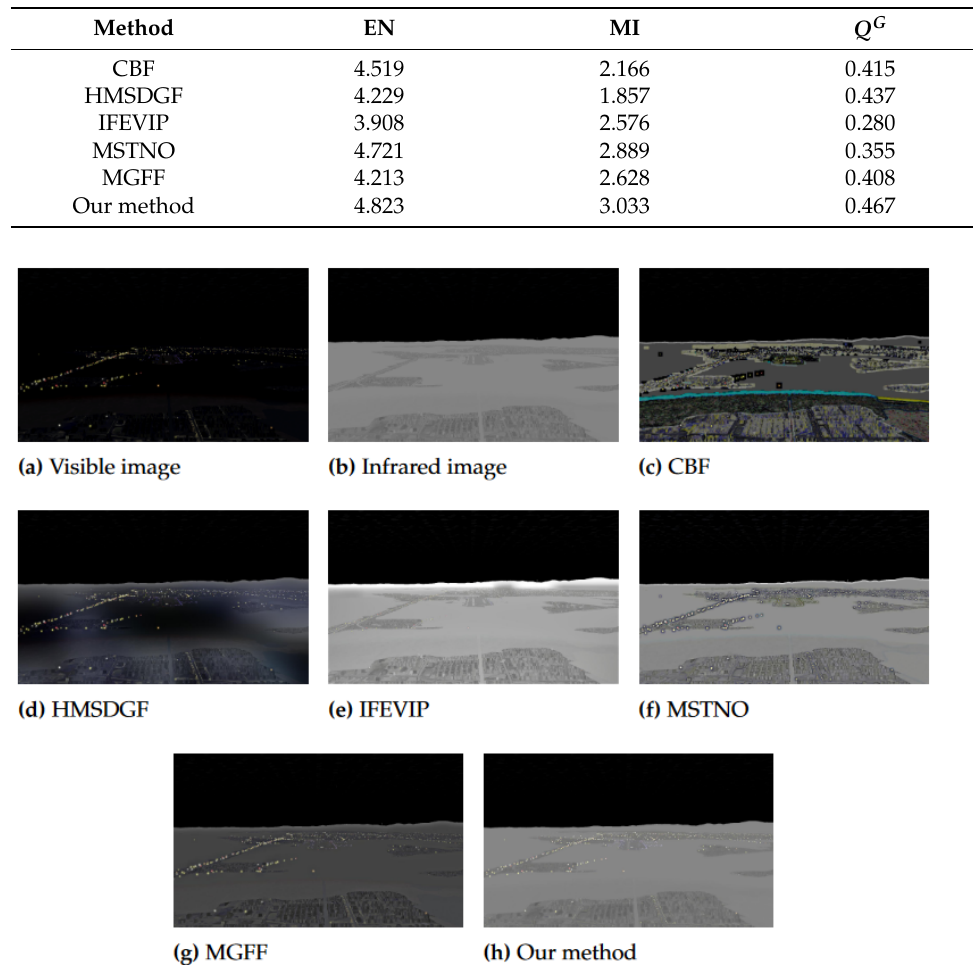
Table 6. Quantitative comparison between different fusion methods.